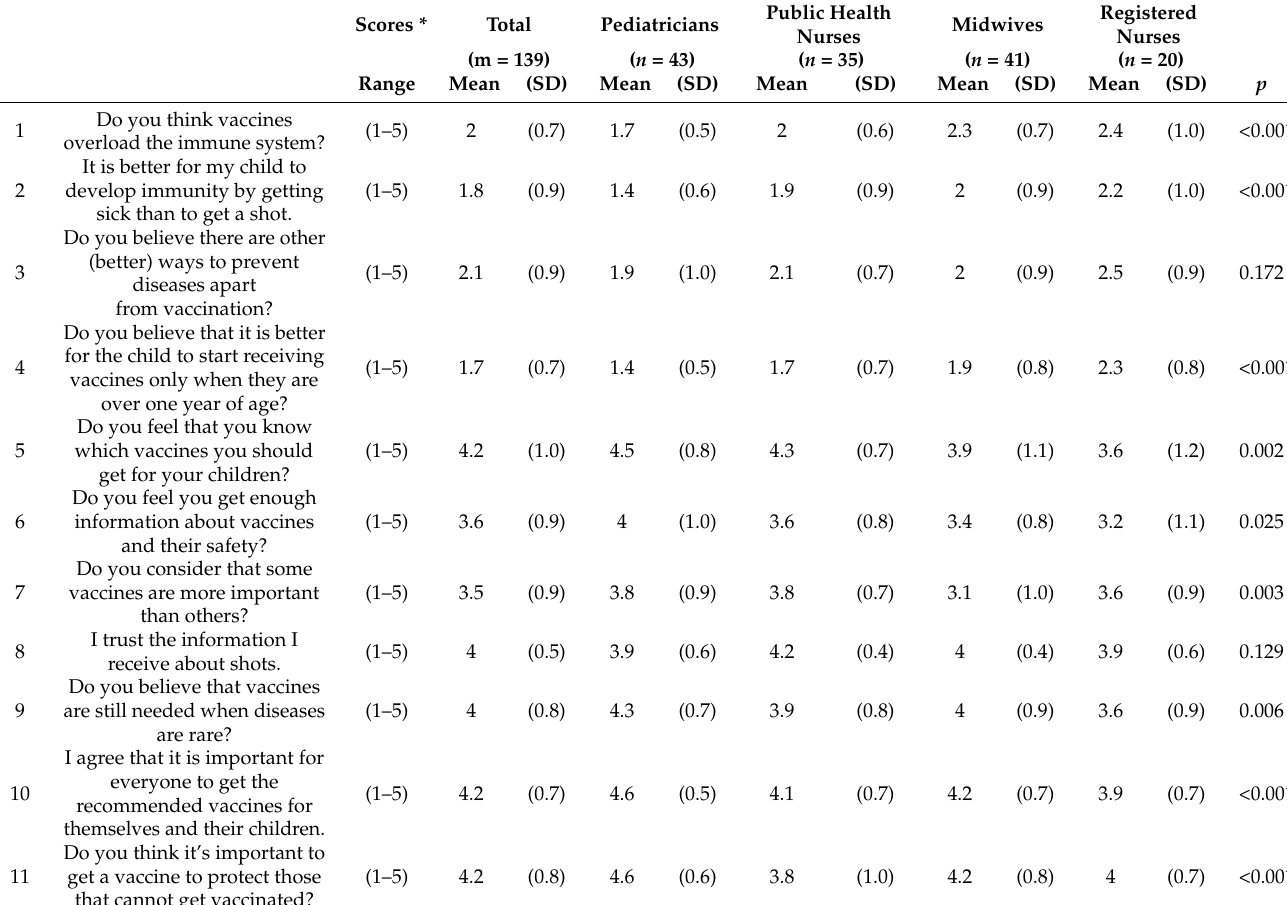
Table 5. Scores of individual social group influences among healthcare